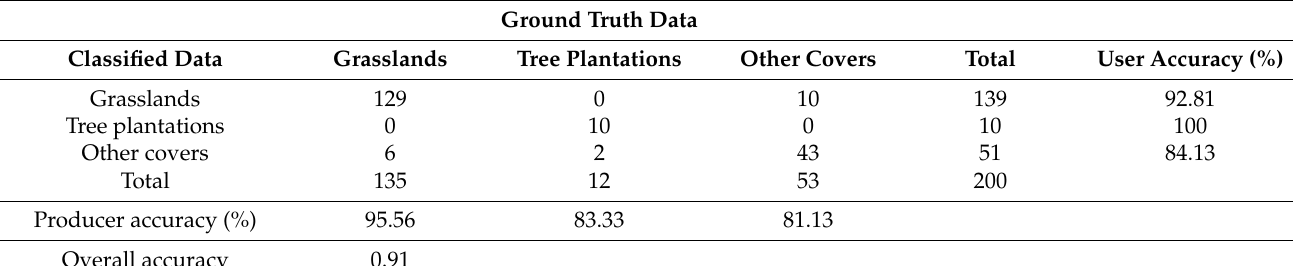
Table A16. Error matrix for the unsupervised classification for the period 2006–2007 based on 200 random points distributed across the Aguapey VGA. The diagonal contains correctly classified pixels.